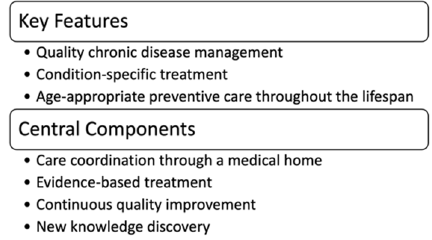
Figure 1. ACHDNC Statement on LTFU.